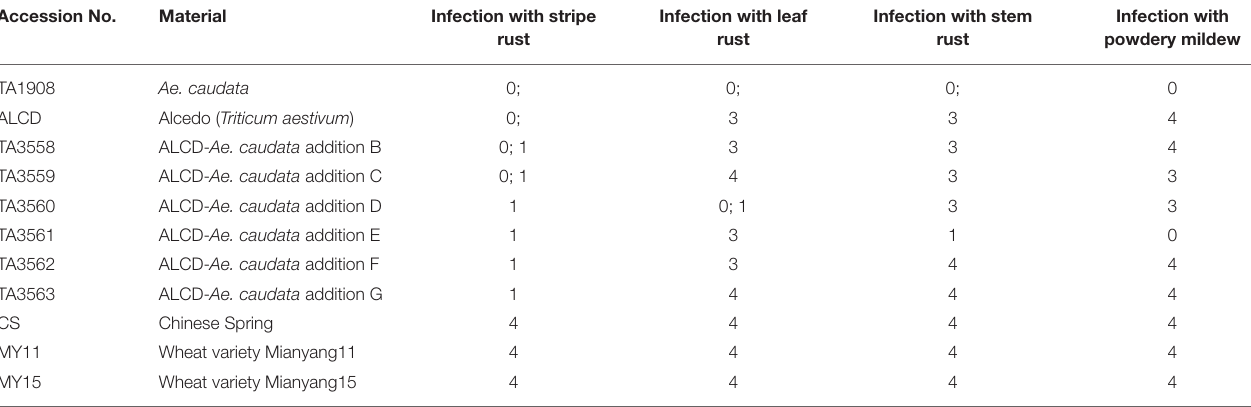
TABLE 1 | Stripe rust, leaf rust, stem rust and powdery mildew resistances of ALCD- Ae. caudata additions. Accession